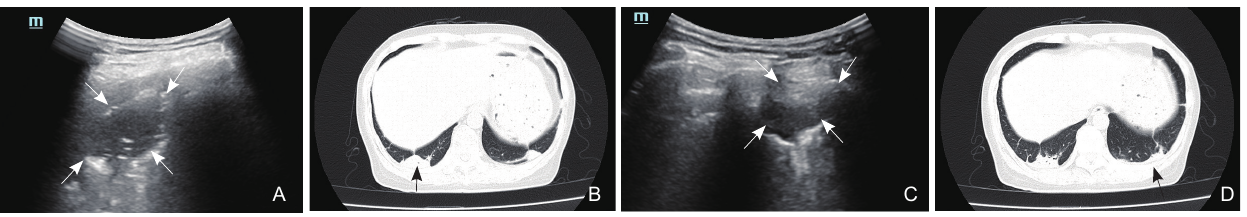
Figure 5 Case 5, a 62-years-old female,. (A and C) Ultrasound observation of lung consolidation (L4, R3) is basically consistent with lung CT findings (B and